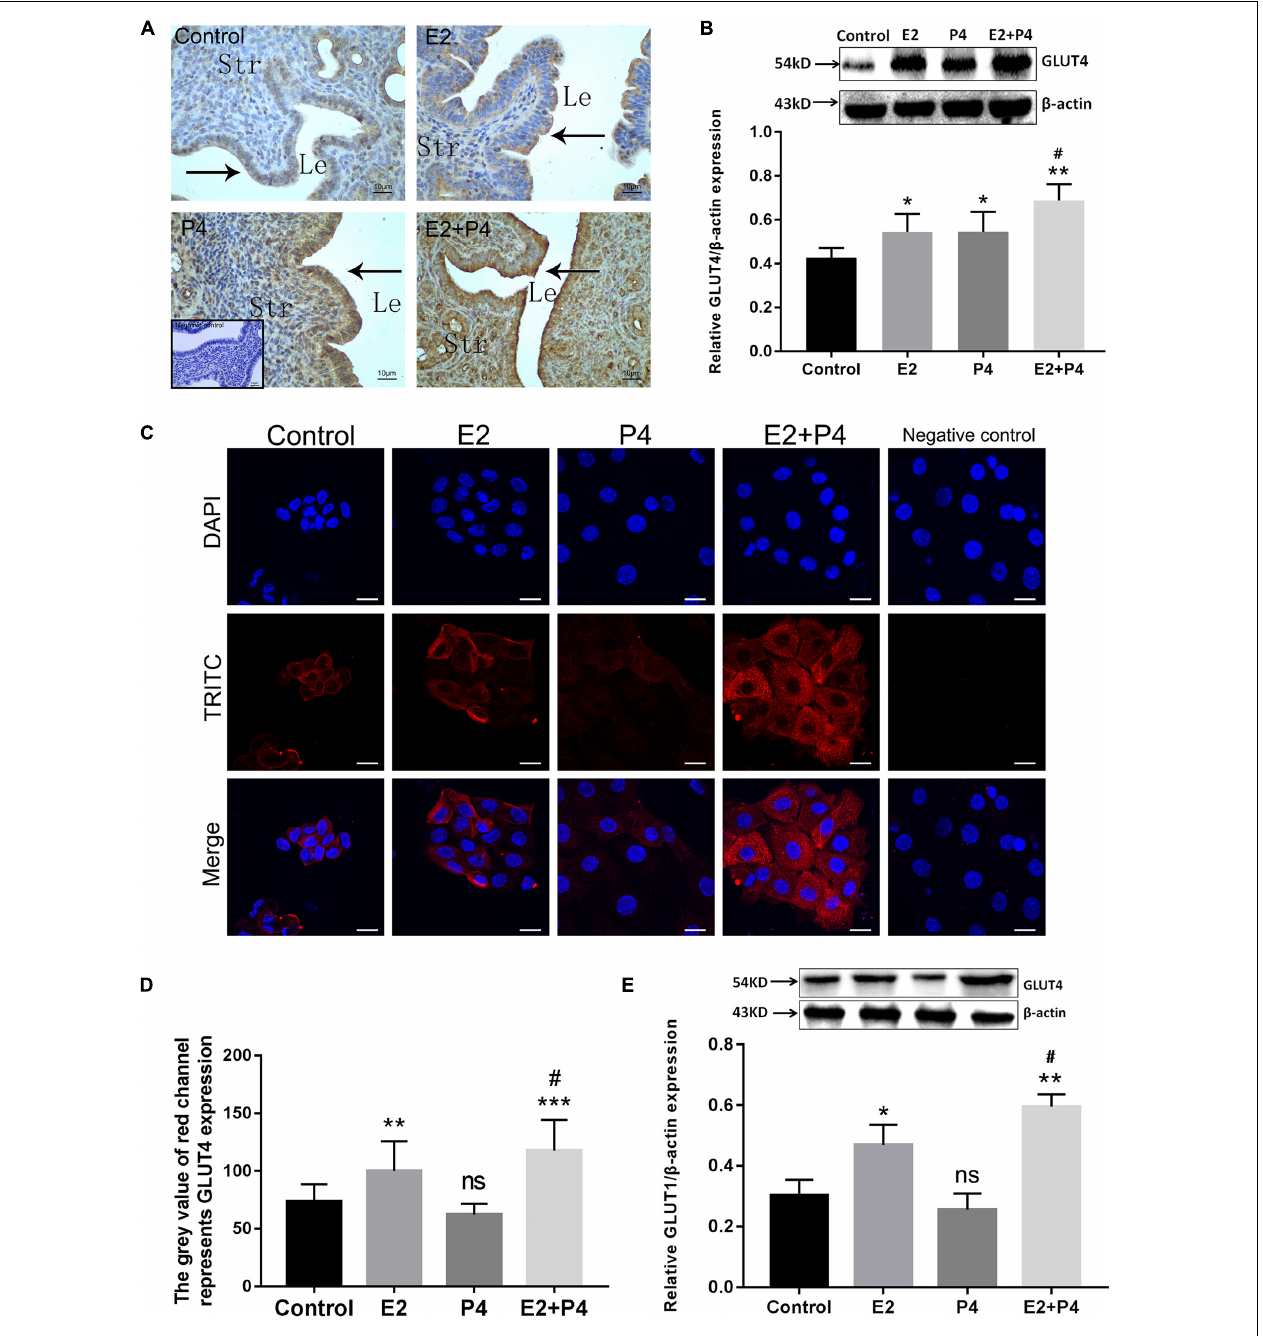
FIGURE 2 | Estrogen and progesterone regulate the expression of GLUT4 in the endometrial epithelium. Mouse uteri were collected at 24 h after the last injection. One side of the uterine horns was fixed in 4% paraformaldehyde for paraffin blocks and the other side was stored at − 80 ◦ C for Western blotting analysis, n = 10 per group. (A) Immunohistochemistry (IHC) staining for GLUT4 expression in ovariectomized (OVX) mouse endometrium 2 days after hormone treatments. Control (oil), E2 (0.2 µ g/day estrogen), P4 (4 mg/day progesterone), and E2 + P4 (0.2 µ g/day E2 + 4 mg/day P4). Negative control is without the primary antibody (shown at the bottom of the left-hand corner ). Le , luminal epithelium; Str , stromal tissue. n = 10 per group. Scale bar , 10 µ m. (B) Western blotting analysis for GLUT4 expression in OVX mouse uterine tissues ( n = 3, normalized by β -actin). (C) Immunofluorescence staining for GLUT4 expression in mouse endometrial epithelial cells (EECs) 48 h after hormone treatments: control (solvent control), E2 (10 − 8 mol/L), P4 (10 − 6 mol/L), and E2 + P4 (combination of 10 − 8 mol/L E2 and 10 − 6 mol/L P4). Negative control is without the primary antibody. The experiment was performed at least three times. Images were taken at × 40. Scale bar , 10 µ m. (D) Quantitative analysis of immunofluorescence staining using Image-Pro Plus 6.0 software. (E) Western blotting analysis for GLUT4 expression in mouse EECs. The cells were harvested 48 h after hormone treatments. Relative density analysis of the GLUT4 proteins by Image Lab 3.0 software ( n = 3, normalized by β -actin). ns, not significant. * P < 0.05, ** P < 0.01, *** P < 0.01 vs. control; # P < 0.05 vs. the E2 group.